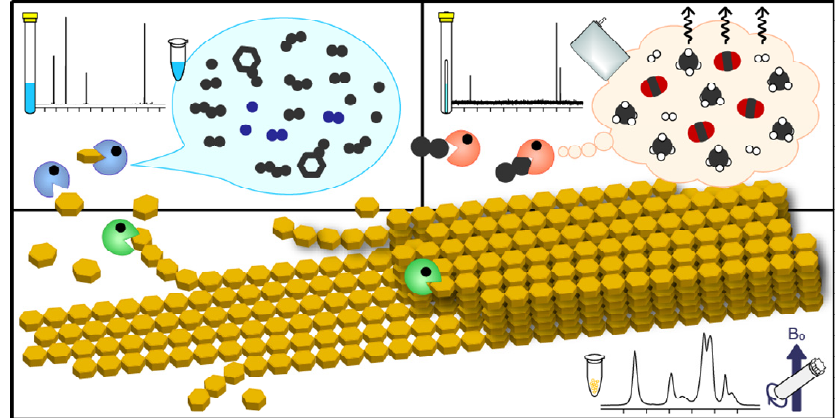
acetate was the main source of CH 2